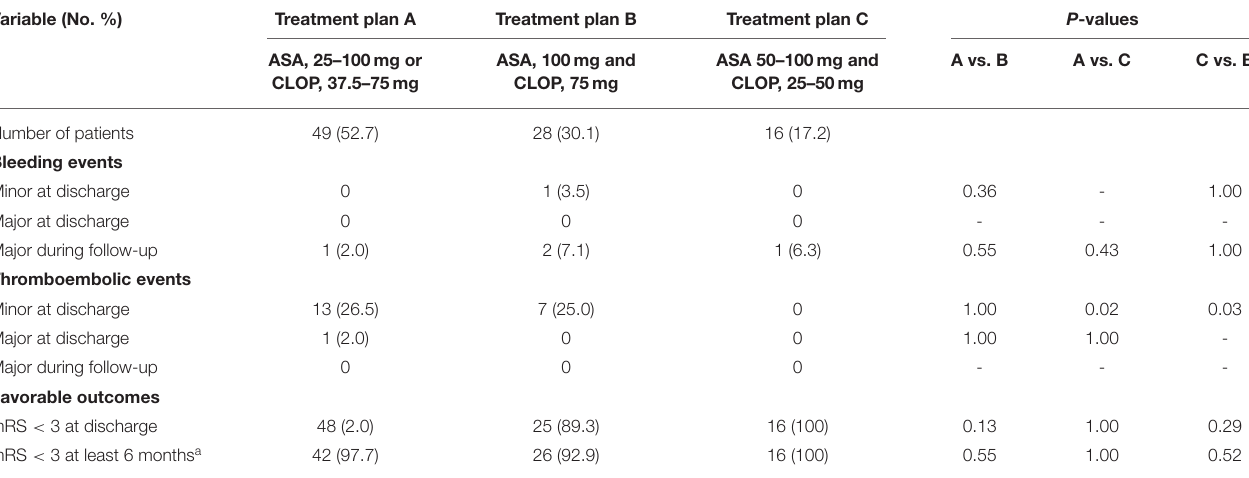
TABLE 4 | Complications and favorable outcomes in patients who underwent SAC with individualized antiplatelet therapy. Variable (No.